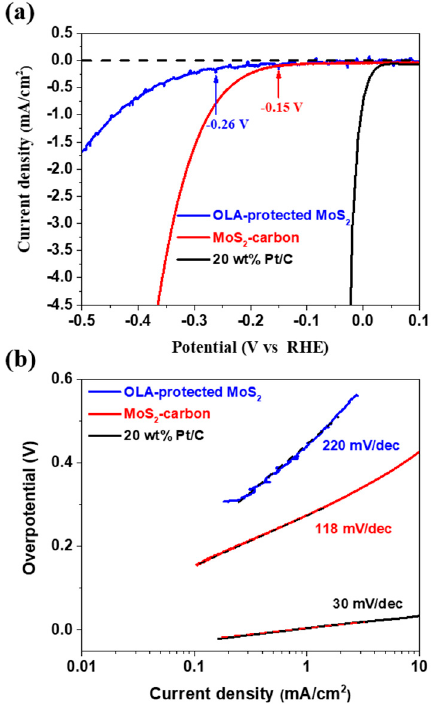
Figure 6. The HER performance of OLA-protected monolayer MoS 2 ( blue ), MoS 2 -carbon ( red ) and 20 wt% Pt / C. ( a ) The polarization curves and ( b ) the corresponding Tafel plots obtained using a glassy carbon working electrode with a catalyst loading of 0.28 mg / cm 2 and a scan rate of 5 mV /